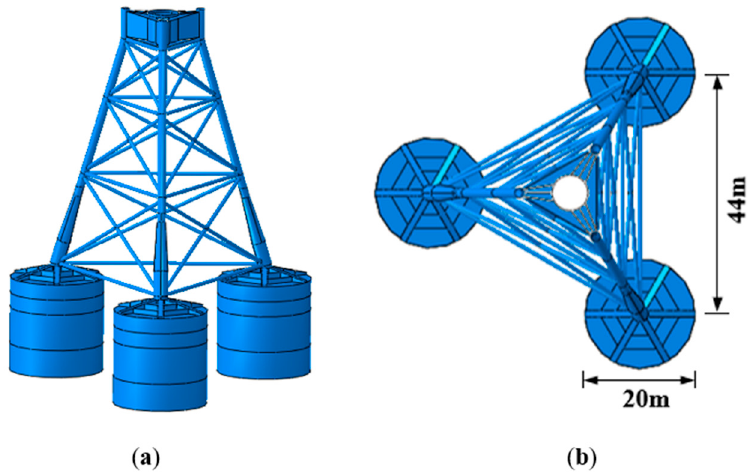
Figure 5. Schematic diagram of the prototype. ( a ) Overall view. ( b ) Top view.